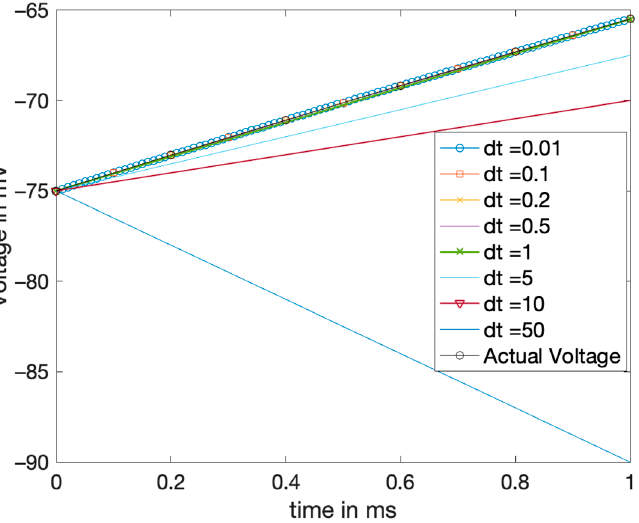
Figure 4. Stability analysis for Heun’s method: Solutions with different step sizes ‘dt’ plotted and the behavior in matching true solutions observed .